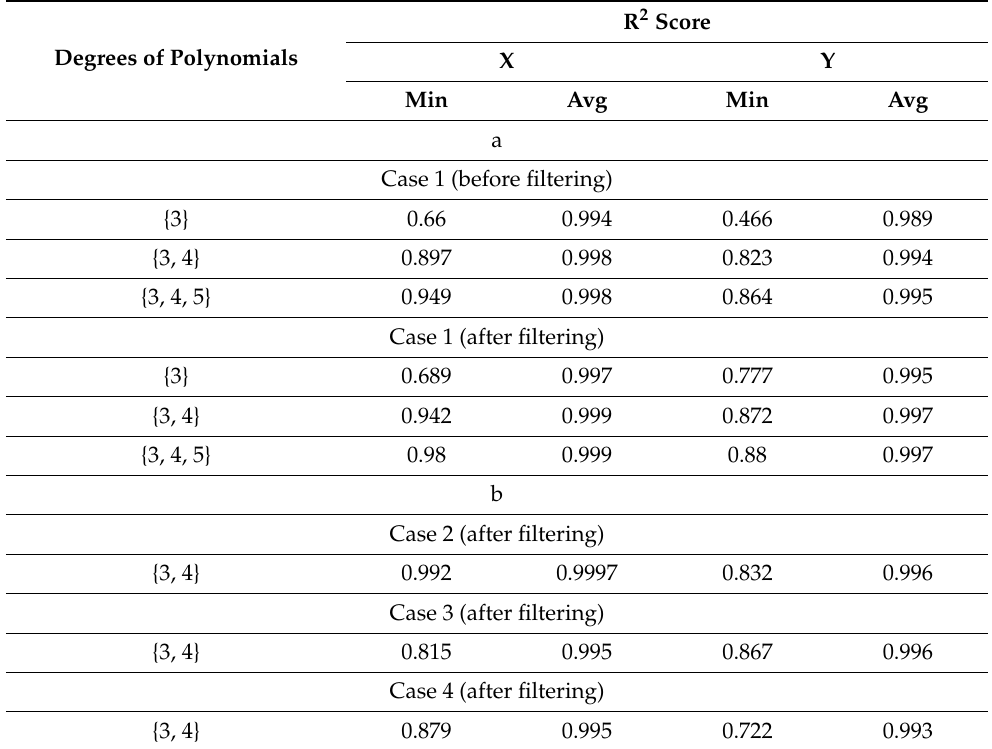
Table 1. (a) Evaluation of trajectory approximation polynomials. (b) Evaluation of trajectory approxi- mation polynomials (Cases